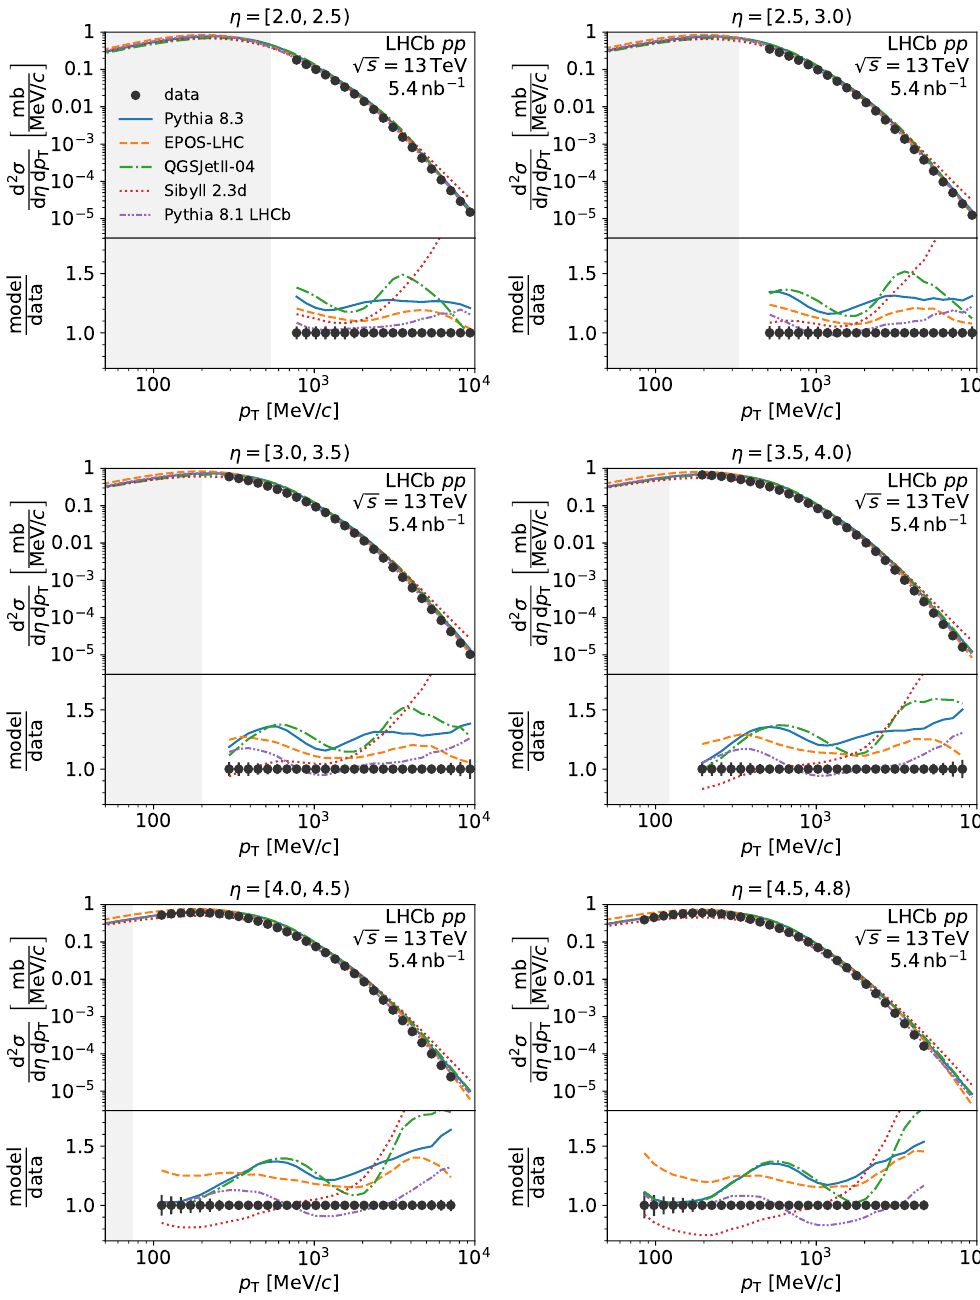
Figure 10 . Differential cross-section of inclusive production of prompt long-lived charged particles in intervals of pseudorapidity, η , and as a function of transverse momentum, p T . The error bars indicate the total uncertainty. The ratios of the model predictions and this measurement are shown in the lower panels. The lines labelled as Pythia 8.1 LHCb correspond to the occupancy-weighted simulated samples of this